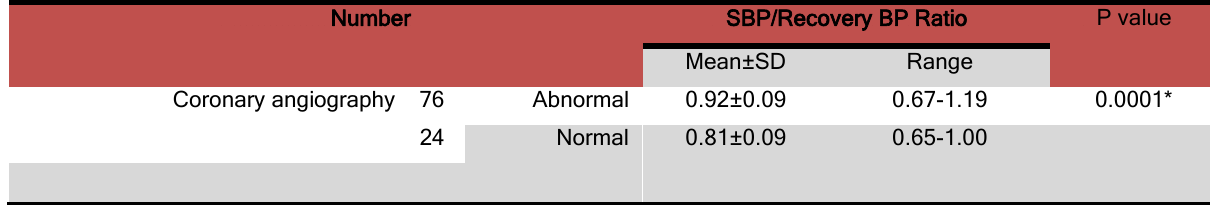
TABLE(4) mean SBPR in normal and abnormal coronary angiography